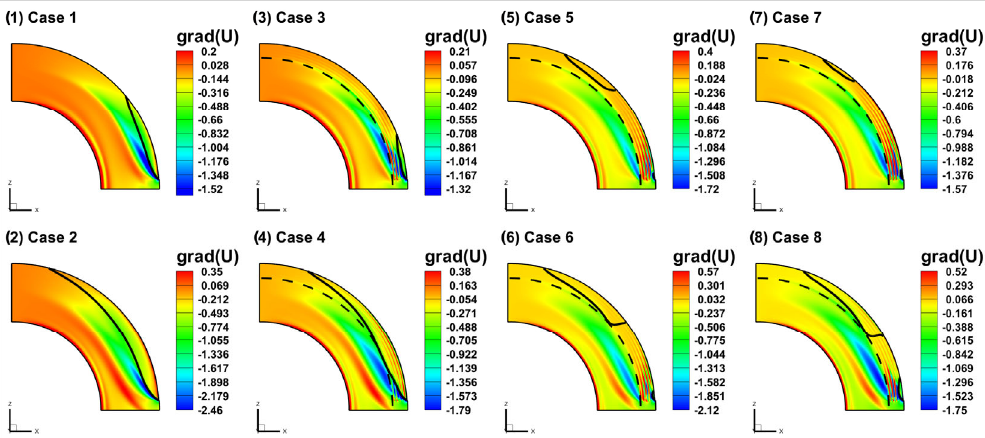
Figure 10. Contours of radial gradient of streamwise velocities on the vertical section near the water surface in the curved reach after the confluence point. (The black dashed line and black solid line in the figure represent the edge of vegetation region and the border of separation zone, respectively).